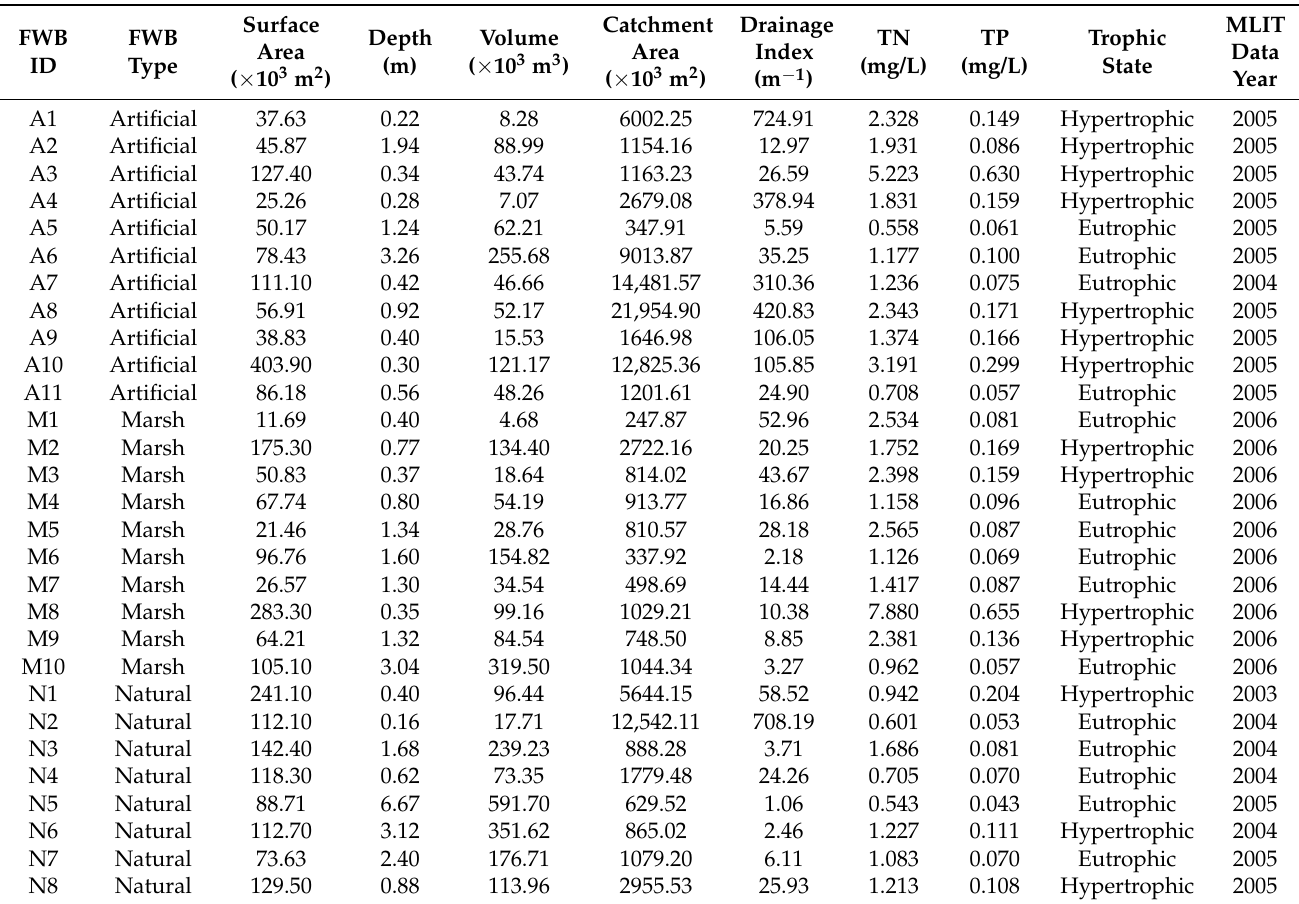
Table 1. General characteristics of floodplain waterbodies (FWBs) in the Ishikari River. The names of FWBs are provided as codes whose location is shown in Figure 1. Catchment area was estimated by including 200 m buffer area around the water edge, 100 m buffer areas on both sides of agricultural channels that drained through the areas not defined by topography, and other all topographically-defined catchment contributing to FWBs (see the text in more details about estimation method). Total nitrogen (TN) and total phosphorus (TP) of surface water were showed in mean values of data from MLIT and survey in 2019 (water quality data was collected in summer and autumn in both data sets) as an index of trophic